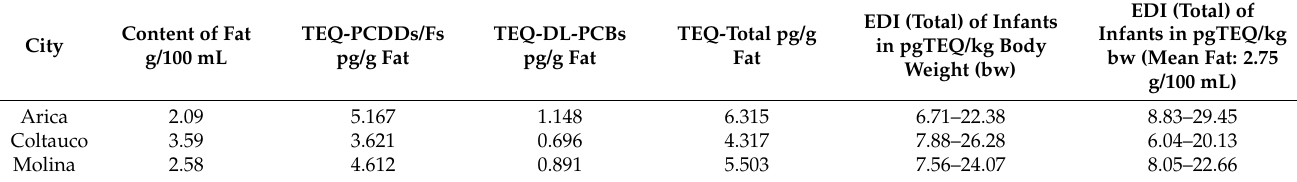
Table 2. The equivalent toxic concentrations (WHO-TEQ) of dioxin-like polychlorinated biphenyls (DL-PCBs), polychlo- rinated dibenzodioxins (PCDD), and polychlorinated dibenzofurans (PCDF) of the pooled samples and estimated daily intakes (EDI) of infants in 3 regions of Chile.